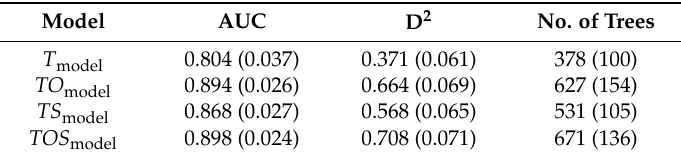
Table 2. Receiver operator characteristic curve area under the curve (AUC), explained deviance (D 2 ) model performance statistics, and number of trees per model averaged over the 50 iterations conducted per model; standard deviation between the 50 models shown in brackets.